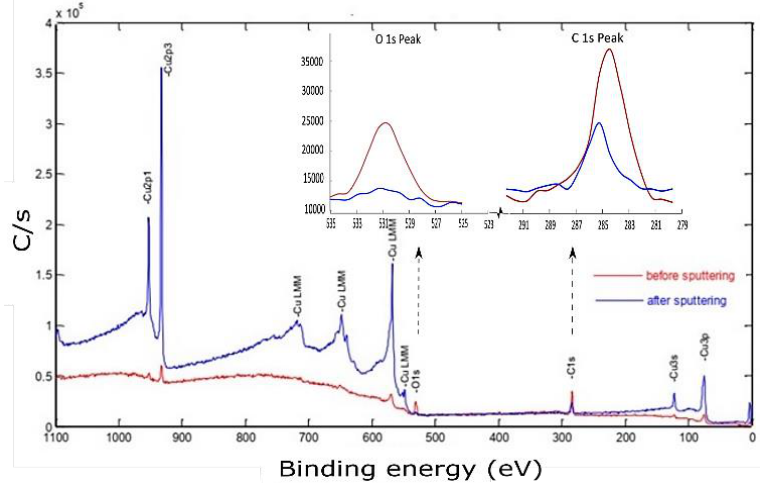
Figure 14. X-ray photoelectron spectroscopy of the Cu sample fabricated by L-PBF under 370 W laser power, 500 mm/s scanning speed, and 0.1 mm hatch spacing, using a polished sample before and after sputtering.